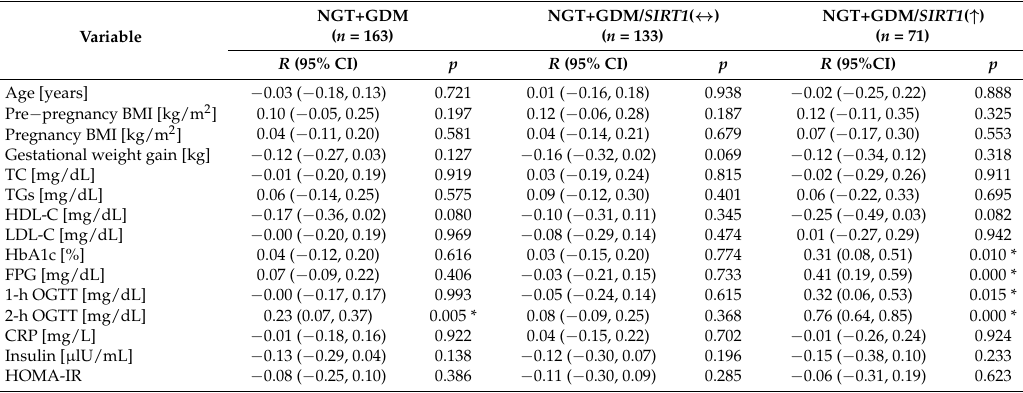
Table 2. Spearman correlation analysis of leukocyte SIRT1 gene expression with clinical parameters in the entire study